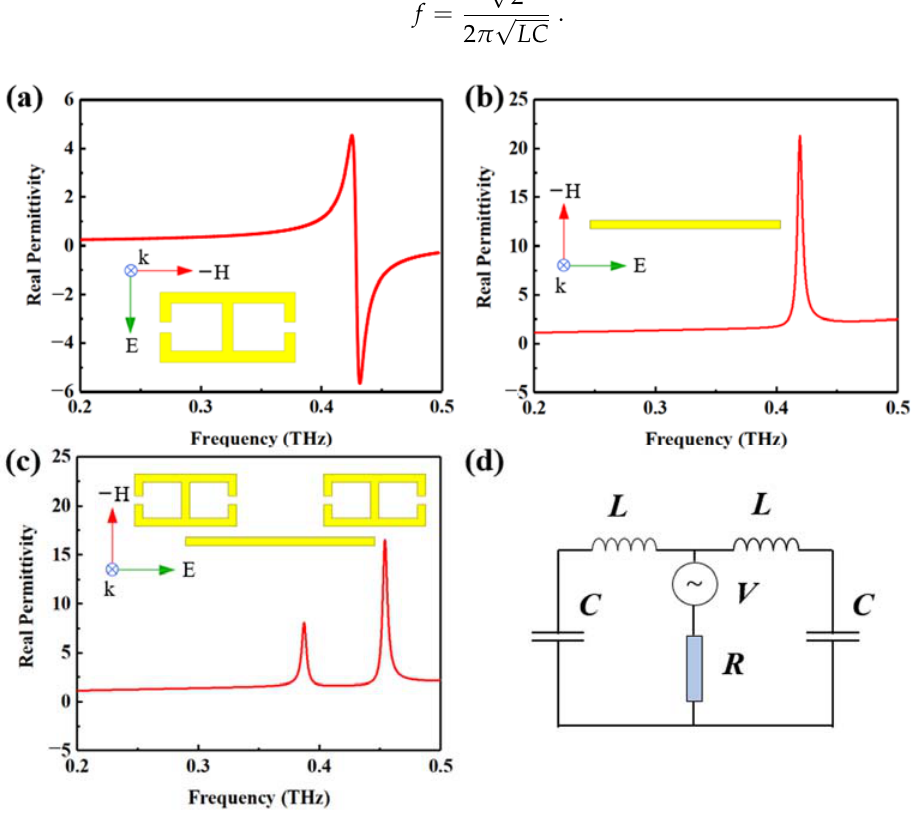
Figure 2. ( a – c ) Real part curves of the permittivity of the ELC resonator, CW, and EIT MTM unit cell. The insets and coordinate systems show the corresponding unit cells and the polarization direction of the incident waves. ( d ) Equivalent circuit of the ELC resonator.